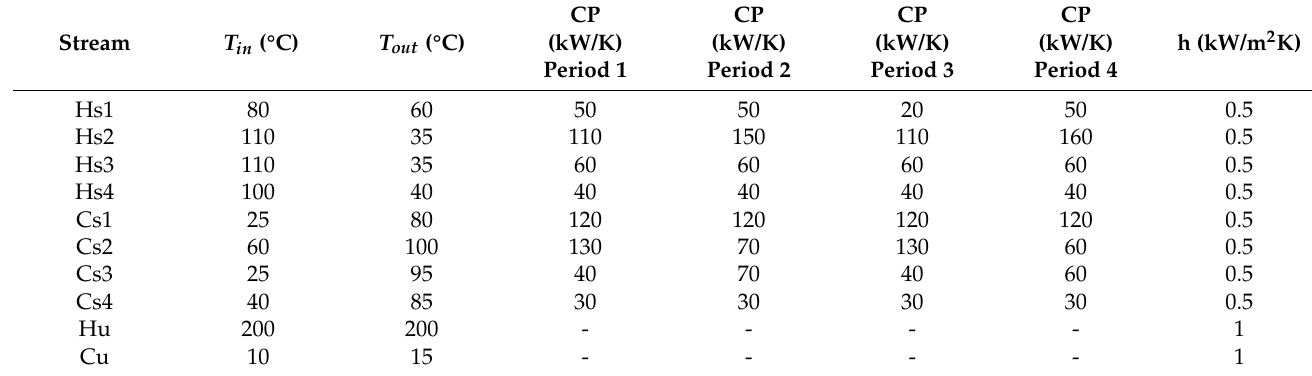
Table 3. Stream data for case 3.